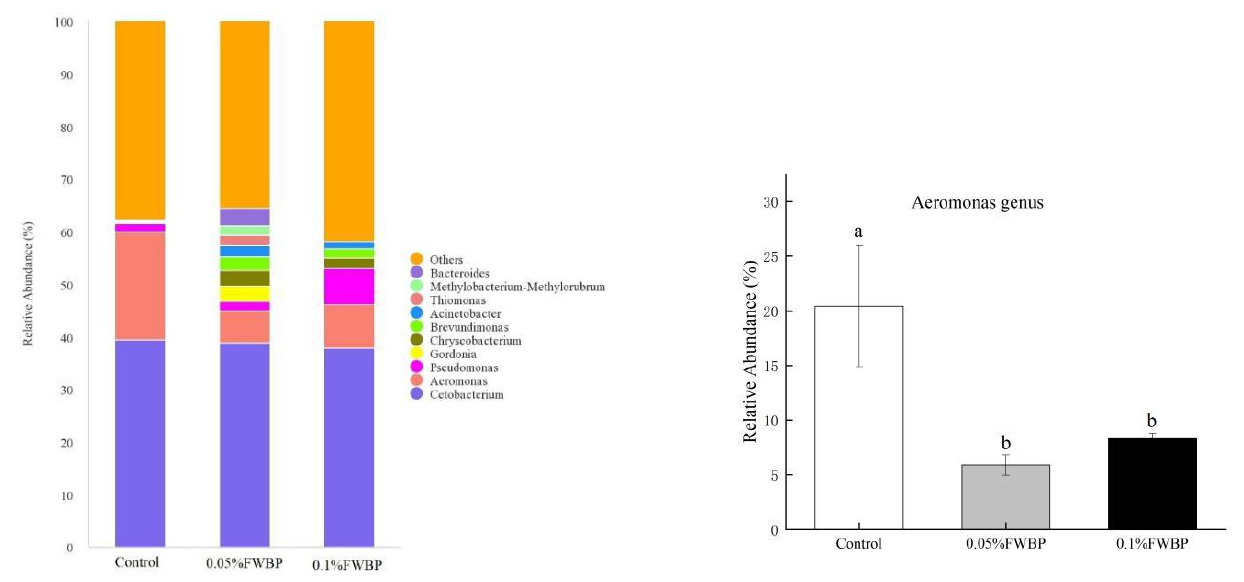
Figure 10. Microbial community in zebrafish fed with FWBP at the genus level. FWBP: Fermented wheat bran polysaccharides. Different lowercase superscript letters denote statistically significant differences among different groups ( p < 0.05).